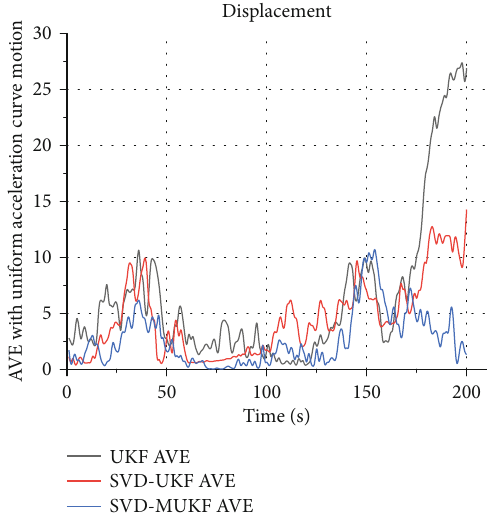
Figure 10: AVE with uniform acceleration curve motion (velocity). Table 6: Mean, variance, and RMSE of algorithm velocity